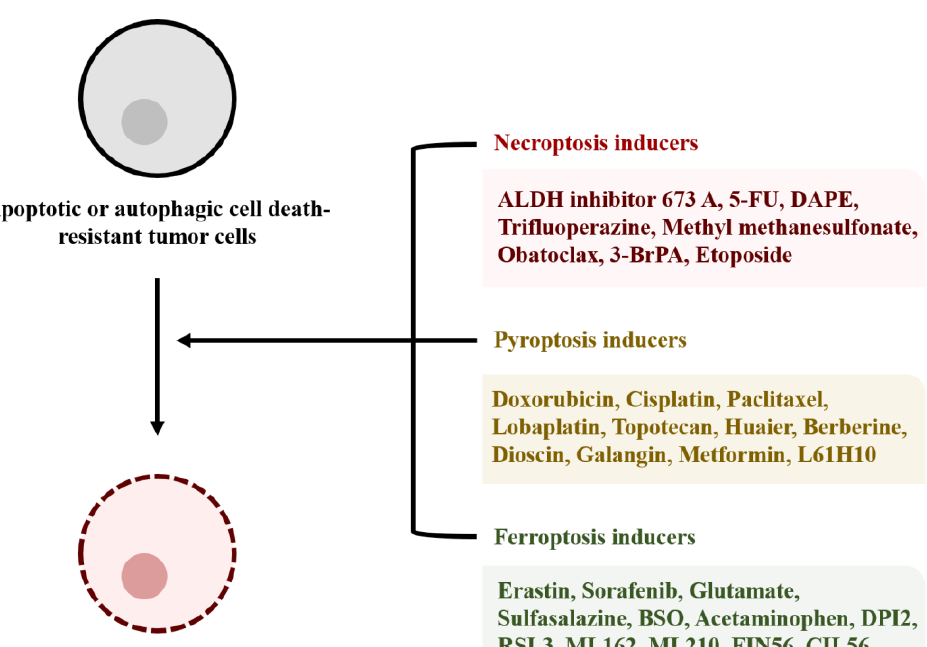
Figure 3. Inducers of RNCD. RNCD inducers can be used to induce cell death of tumor cells that are resistant to apoptotic or autophagic cell death. RNCD inducers can cause membrane disruption of the tumor cells and subsequent inflammatory responses in the tumor tissues. The appropriate administration of the inducers according to tumor types may be effective tumor therapies. Aldehyde dehydrogenase (ALDH1A) inhibitor; 5-fluorouracil (5-FU); 1,2-diarachidonoyl-sn-glycero-3-